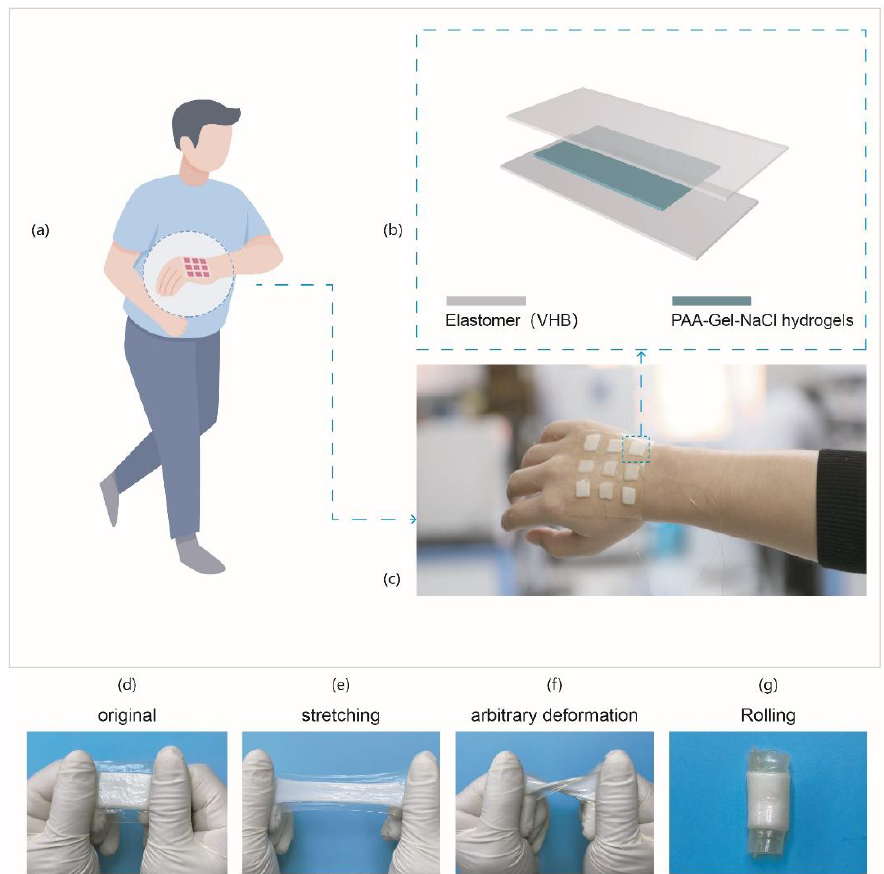
Figure 1. ( a ) Schematic diagram of electronic skin wearing model based on SH-TENG. ( b ) Scheme of the SH-TENG with sandwich structure. ( c ) An optical picture of an array SH-TENG patch attached to the back of the hand. ( d ) Original. ( e ) Stretching. ( f ) Arbitrary deformation. ( g ) Rolling.